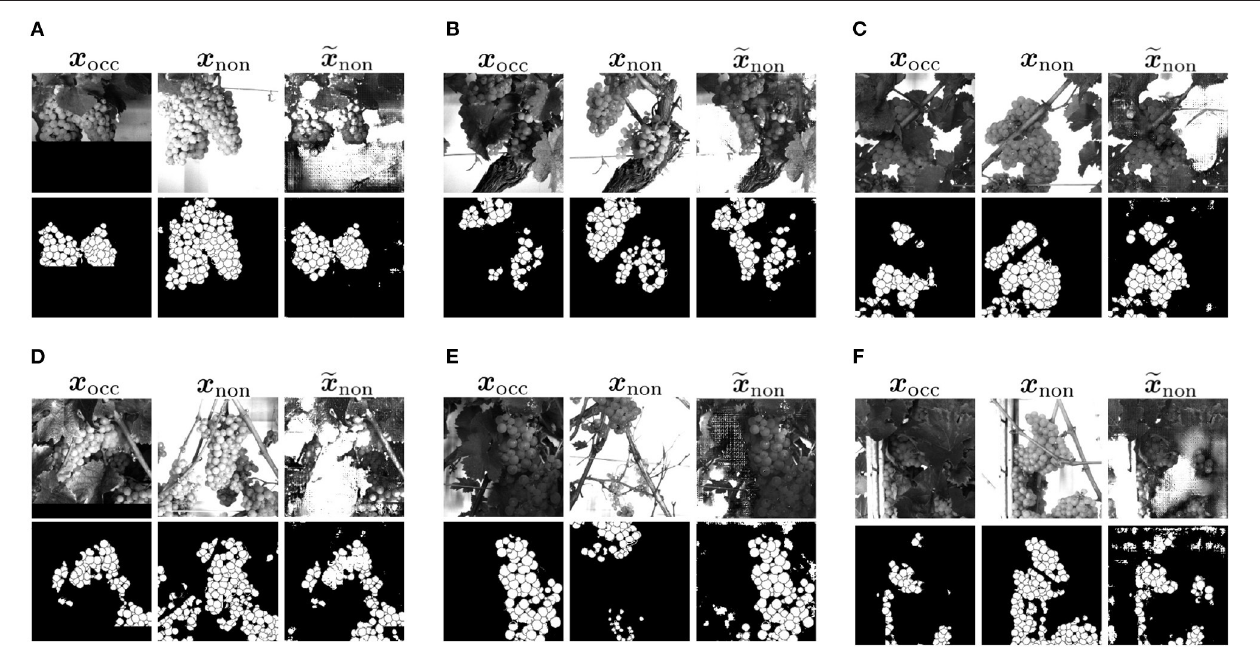
FIGURE 14 | Visual representation of generated result based on natural data input. (A–C) Examples with a good transformation between the patches. They are present as a minority in the natural dataset. (D,E) Show examples with a insufficient transformation between the patches. (F) Shows an example with artifacts in the generated